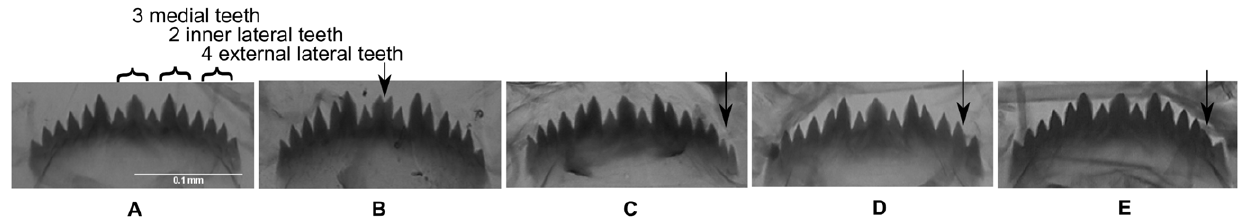
Figure 2. Normal and deformed mentum observed in chironomids exposed at lead and at 4-NP. Normal mentum (A), cleft median tooth (B), extra tooth (C), missing tooth (D), fusing teeth (E). Arrows indicate deformities.